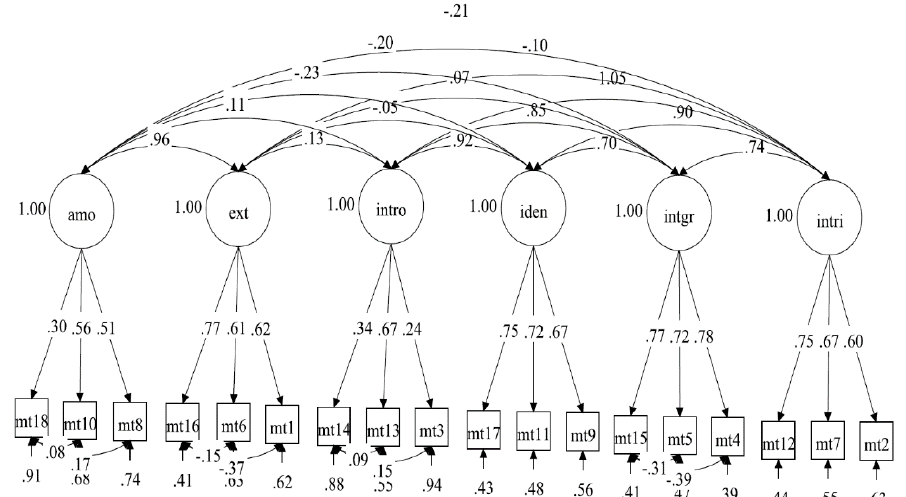
Figure 1. The standardised item loading for the measurement model. Note. amo = amotivated, ext = external, intro = introjected, iden = identified, intgr = integrated, intri = intrinsic. The internal consistency coefficients measured by Cronbach’s alpha were : 0.718 for intrinsic, 0.734 for integrated, 0.752 for identified, 0.462 for introjected, 0.617 for external, and 0.526 for amotivation (refer to Table 3). These values revealed that the SMS had acceptable to excellent stability over time. The ICC values for the six subscales were 0.90